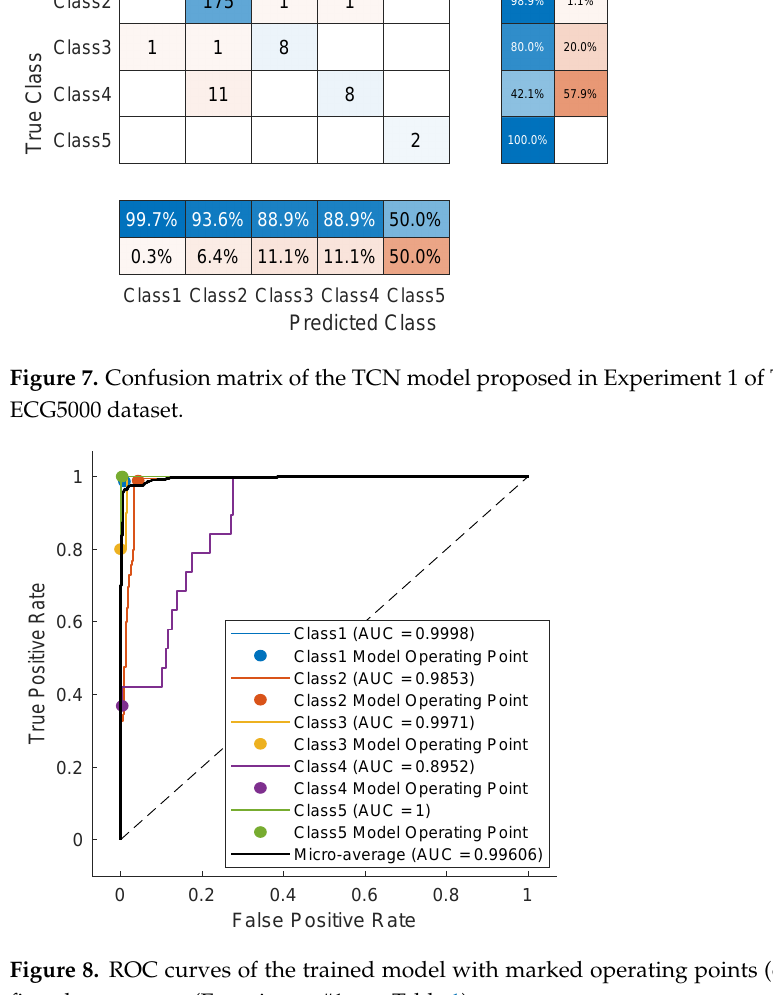
Figure 8. ROC curves of the trained model with marked operating points (dots) obtained for the five-class use case (Experiment #1, see Table